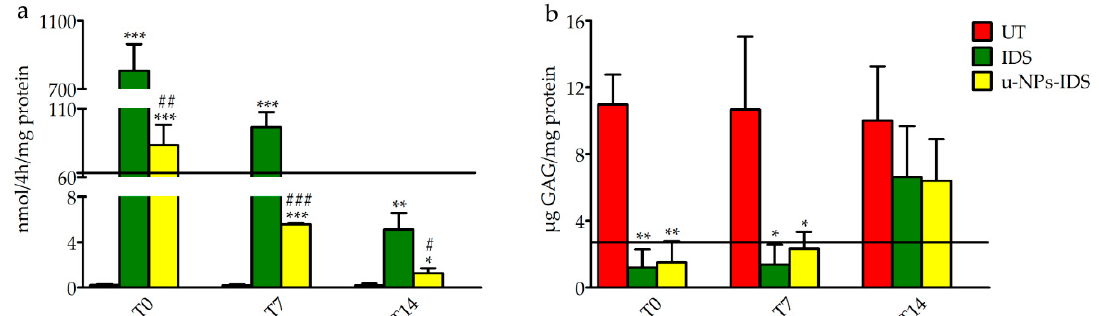
Figure 1. Induced IDS activity and GAG levels in treated fibroblasts. ( a ) Induced IDS activity expressed in nmoles of 4MU (4-Methylumbelliferyl) released in 4 h per mg of protein (nmol / 4 h / mg protein) and ( b ) GAG content ( µ g GAG / mg protein) after 7 days treatment in fibroblasts from MPSII patients ( n = 3). Type of treatment: untreated MPSII fibroblasts (UT), free IDS (IDS), untargeted NPs loaded with IDS enzyme (u-NPs-IDS). The solid horizontal line is the reference value of cells from healthy subjects (mean of 3 samples). The evaluation was carried out 0 (T0), 7 (T7), and 14 (T14) days after the end of the treatment. Data are mean ± SD. For each time point, asterisks indicate a statistically significant di ff erence from UT cells (two-tailed Student’s t -test, * p < 0.05, ** p < 0.01, *** p < 0.001), while hash marks indicate a statistically significant di ff erence between IDS and u-NPs-IDS treated cells (two-tailed Student’s t -test, # p < 0.05, ## p < 0.01, ### p < 0.001). Data are the result of two separate experiments in three di ff erent cell lines and each analysis has been repeated three times in duplicate.